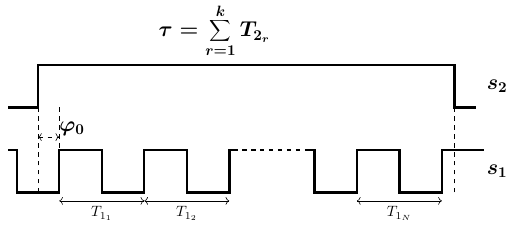
Figure 5: Timings in counting the periods of signal s